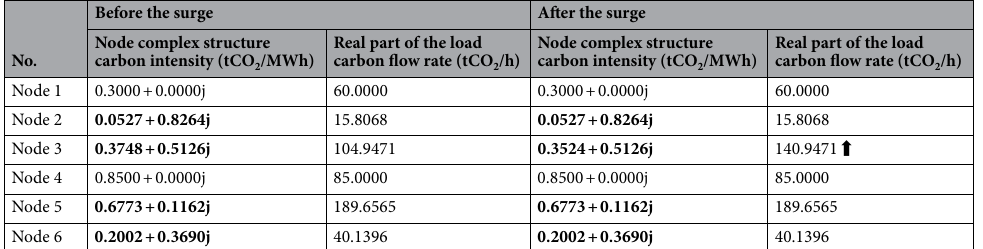
Before the surge After the No.